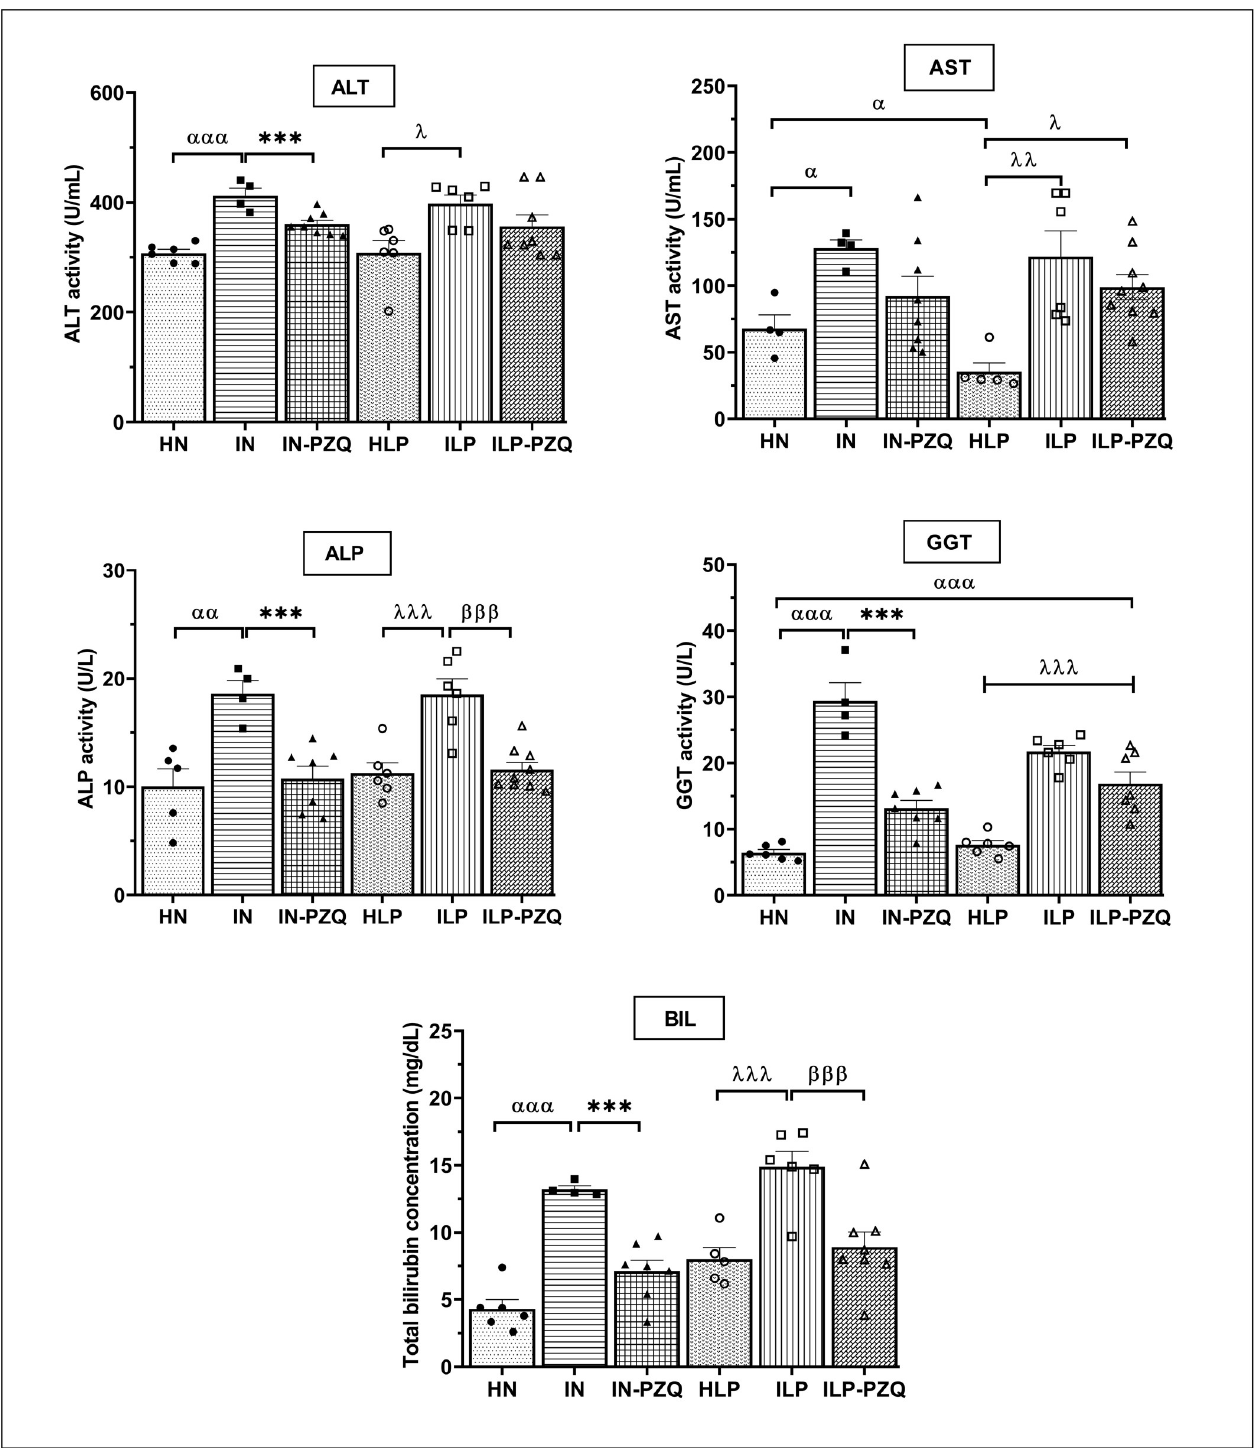
Fig 4. Effects of praziquantel treatment on the liver function biomarkers of Schistosoma mansoni -infected mice receiving a low-protein diet. Data are expressed as mean ± SEM (n = 4–8). AST: aspartate aminotransferase; ALAT: alanine aminotransferase; ALP: alkaline phosphatase; GGT: gamma-glutamyl transferase; BIL: total bilirubin. Group HN: healthy mice receiving a standard diet; group IN: infected-untreated mice receiving a standard diet; group IN-PZQ: infected mice receiving a standard diet and treated with praziquantel; group HLP: healthy mice receiving a low-protein diet; group ILP: infected- untreated mice receiving a low-protein diet; group ILP-PZQ: infected mice receiving a low-protein diet and treated with praziquantel. ANOVA followed by